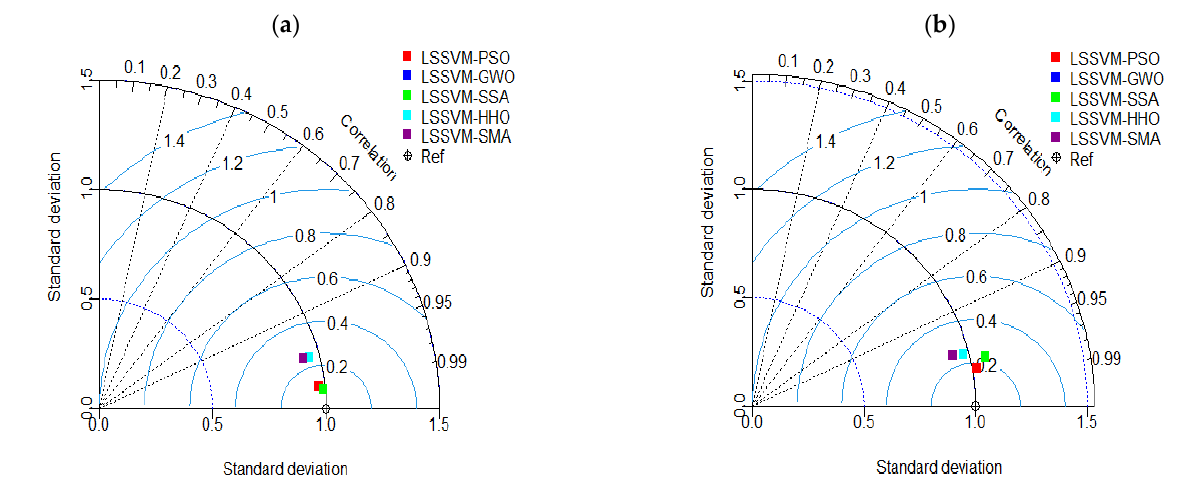
Figure 8. Taylor diagrams for the training ( a ) and testing ( b ) datasets.